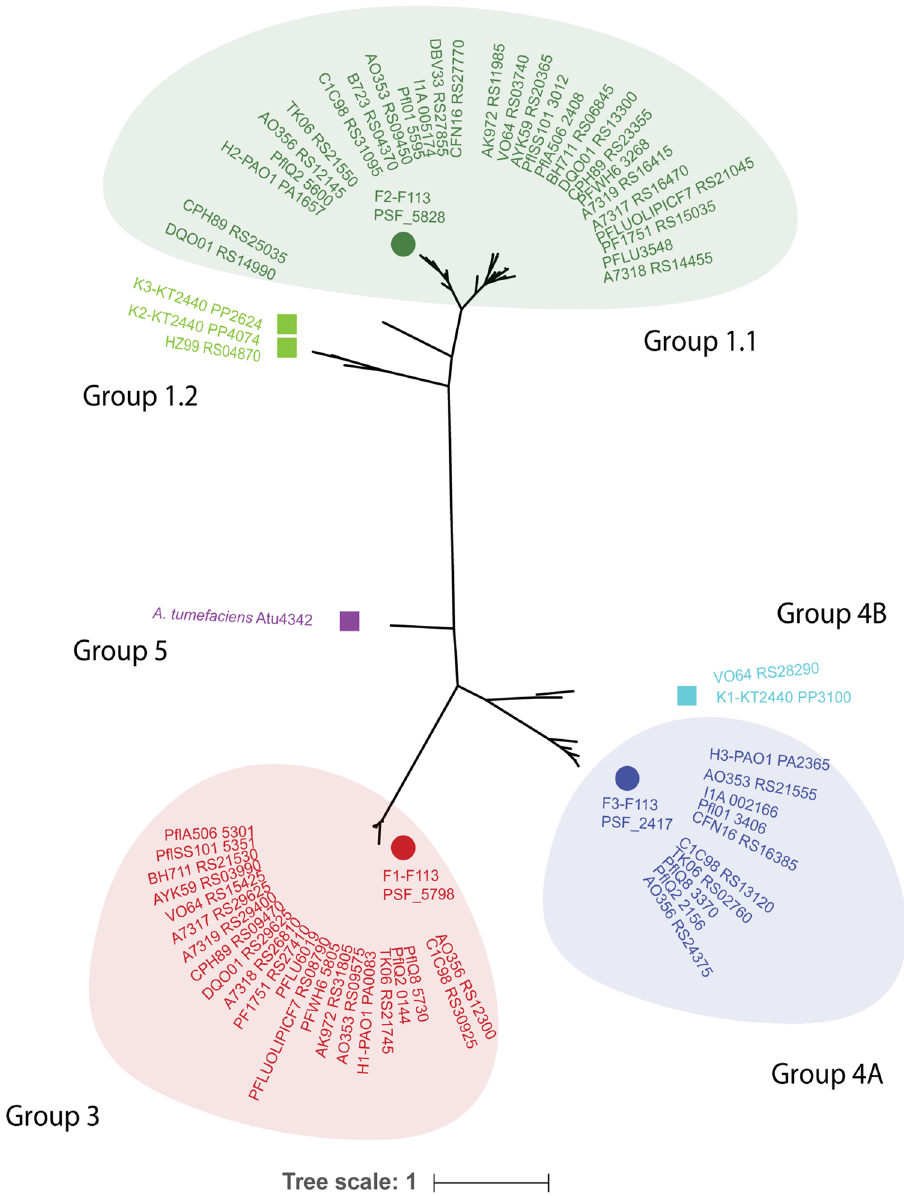
P. fluorescens F113 are divided into three distinguishable groups; 1.1, 3, 4a. The A. tumefaciens TssB was used as an outgroup (group